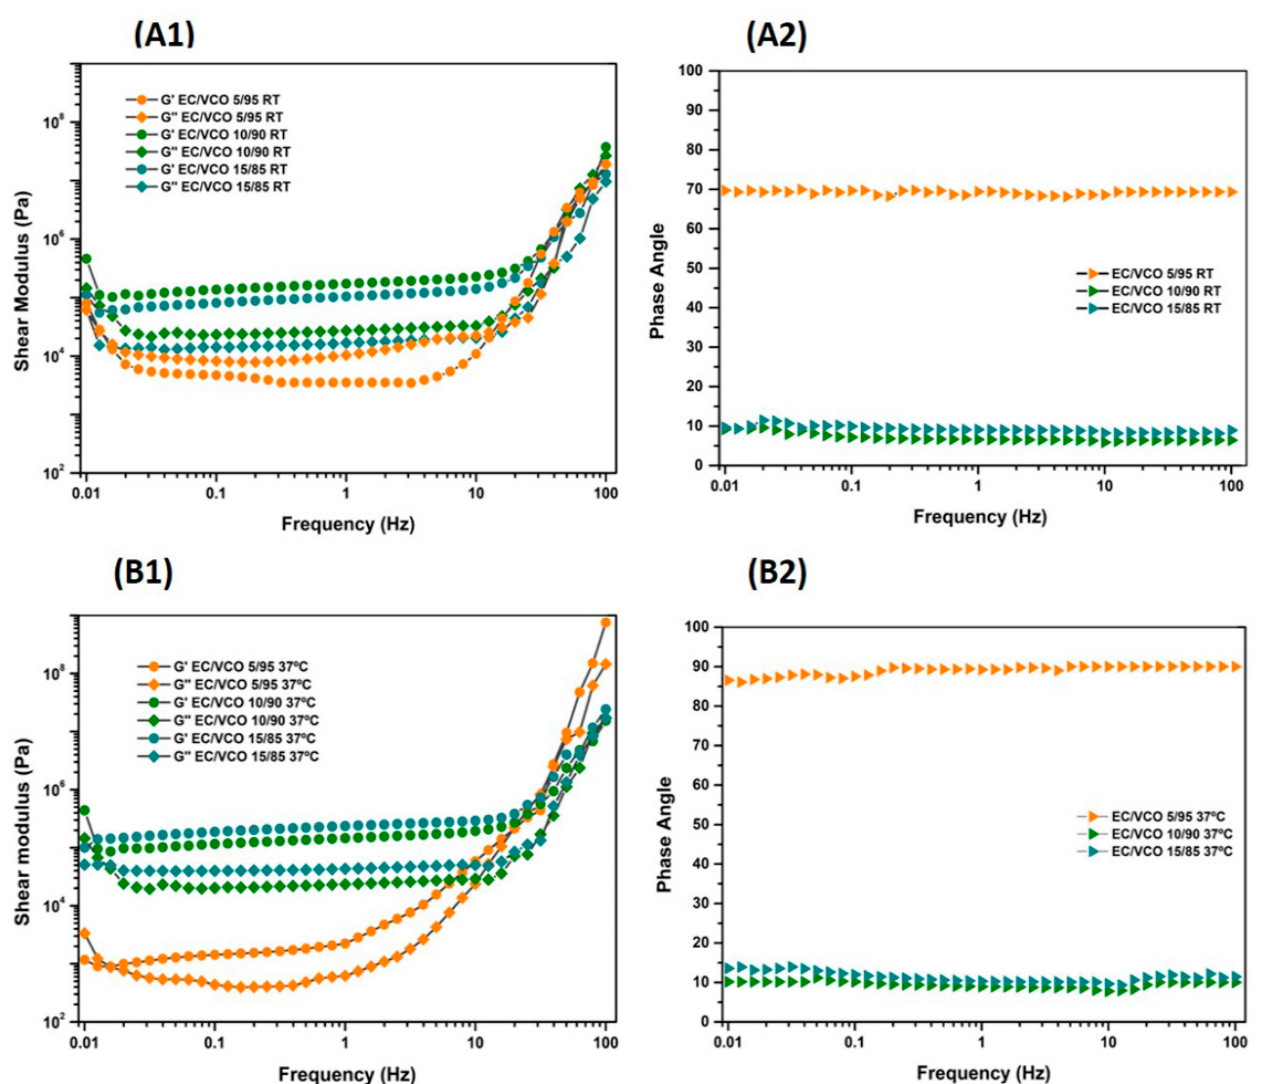
Figure 2. Viscoelastic properties of the molded EC-based ( A1 , B1 )/VCO-based ( A2 , B2 ) oleogels in the function of the frequency, grouped according to the molding temperature: ( A ) RT and ( B ) 37 °C. The loss factor (tan δ value), i.e., the ratio of G ″ /G ′ , defines gel’s strength. For example,